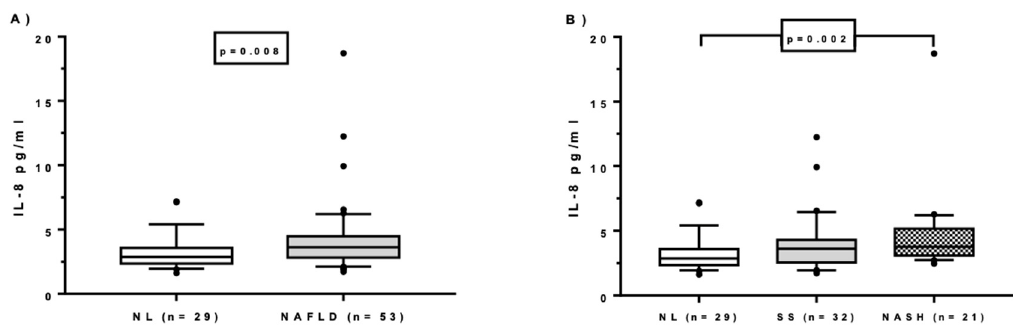
Figure 2. Circulating levels of IL-8 in women with morbid obesity with normal liver and with nonalcoholic fatty liver disease ( A ), and women with morbid obesity according to liver damage ( B ). NAFLD, women with morbid obesity (MO) with nonalcoholic fatty liver disease; NL, women with MO with normal liver; SS, women with MO with simple steatosis; NASH, women with MO with steatohepatitis. p < 0.05 is considered statistically significant.